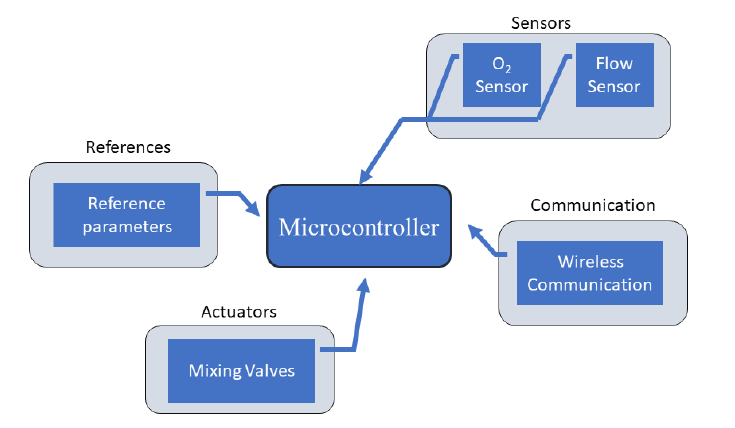
Figure 4. A block diagram of the system proposed by